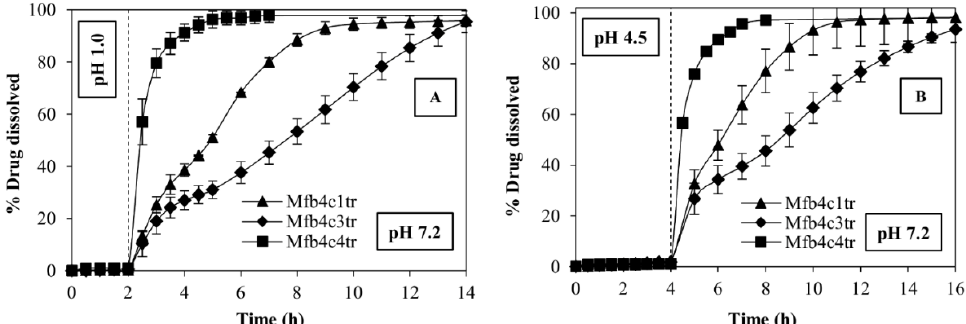
Figure 9. In vitro dissolution profiles of fast release formulation (Mfb4c4tr) and of two sustained release formulations (Mfb4c1tr and Mfb4c3tr) in the two different pH change methods: pH 1.0 for 2 h and then pH 7.2 ( A ), pH 4.5 for 4 h and then pH 7.2 ( B ). All samples contain a dose of 7.5 mg of M. Mfb4c1tr and Mfb4c3tr formulations allow achieving M sustained release. The dose is released at different rates because the percentage of HPMC of high molecular weight used (Methocel K4M) modulates the swelling/release properties in the two formulations (Table 2). Instead, the use of super-disintegrating agents in Mfb4c4tr formulation allows for achieving a fast drug release. Results are supported by the td 90% values (Table 3). Mfb4c3tr needed 5 h more than Mfb4c1tr to reach td 90% in pH 7.2 (after the pH change), and this